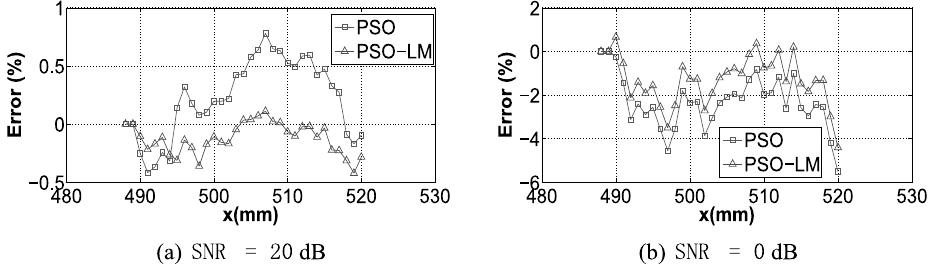
Fig. 19. Relative error in the identi fi cation for a low (0 dB) and moderate (20 dB) levels of SNR, Case 3.